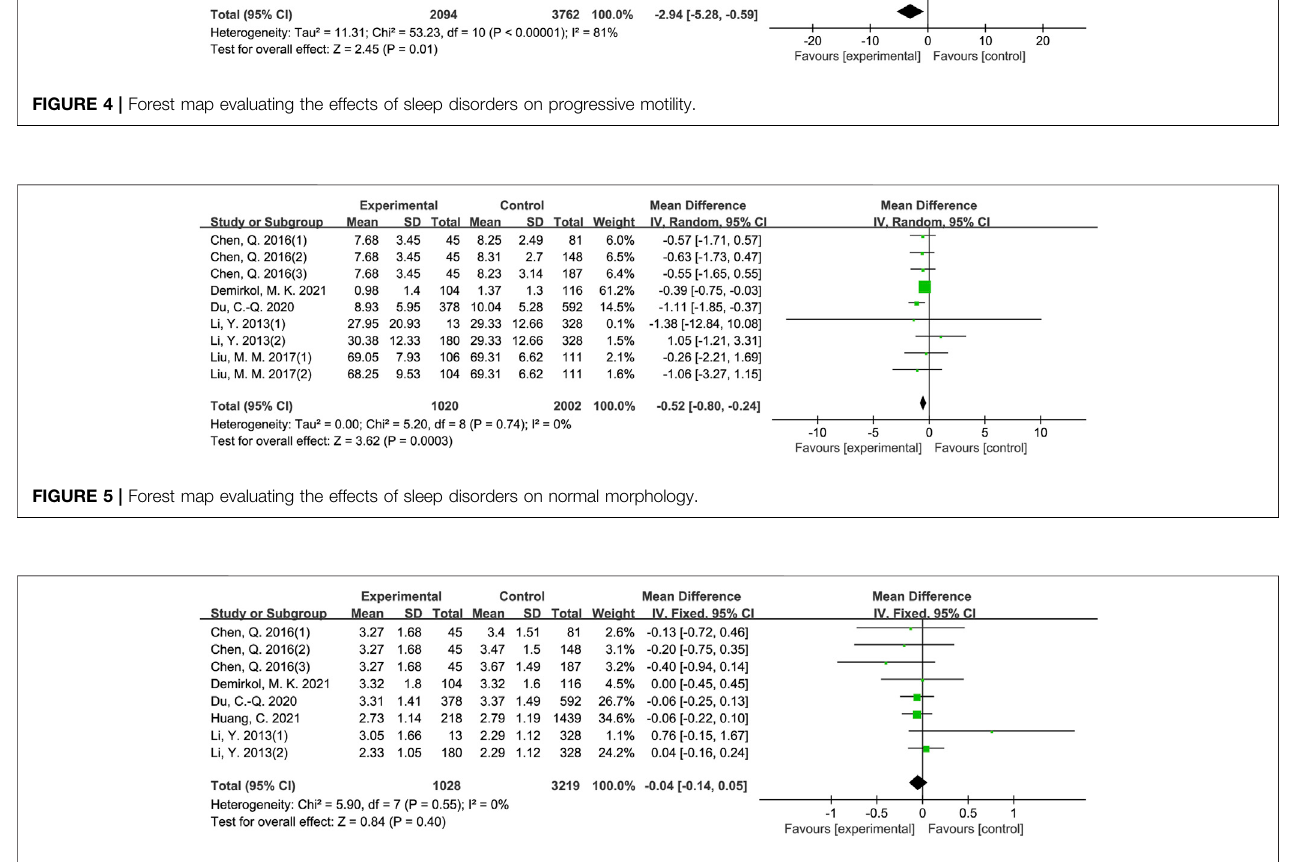
FIGURE 6 | Forest map evaluating the effects of sleep disorders on semen volume.